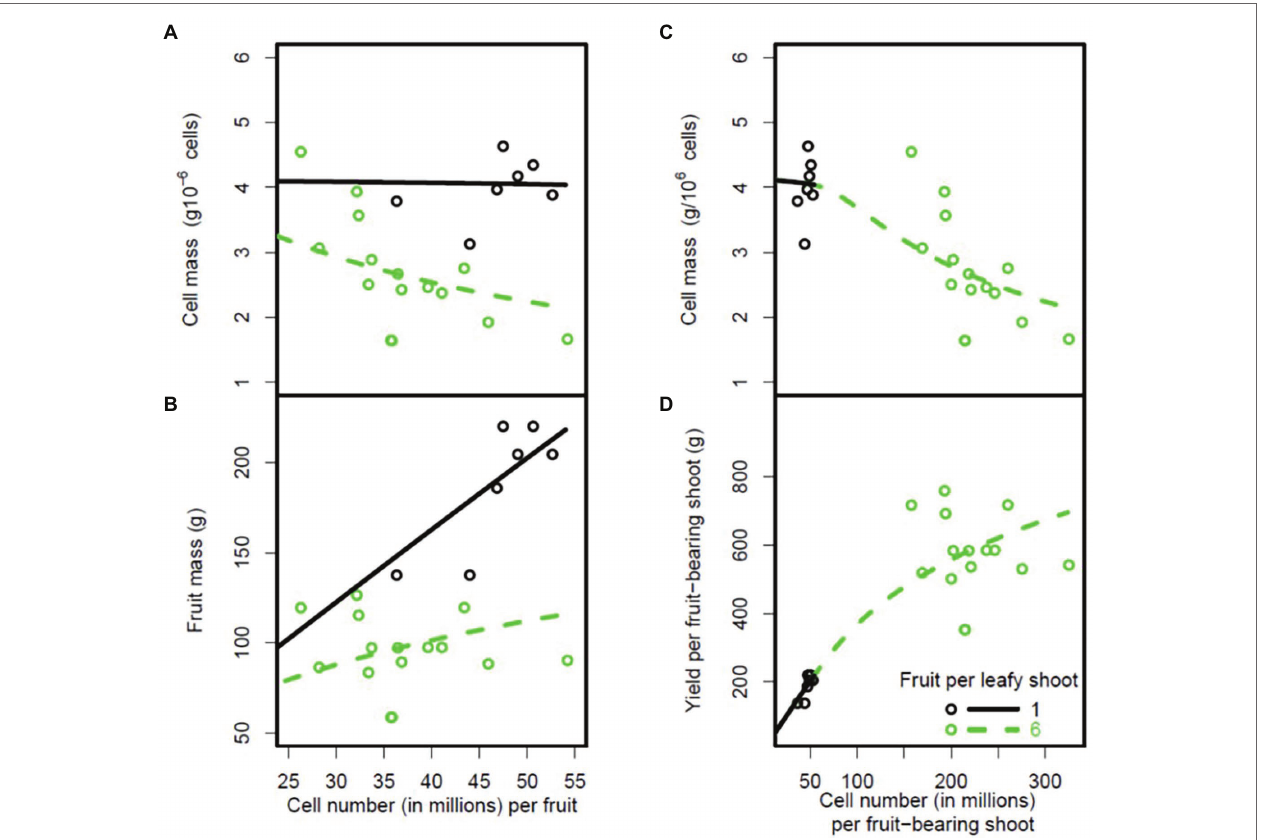
FIGURE 7 | Plots of cell mass and mass of peach fruit mesocarp at fruit maturity against number of cells in the fruit mesocarp (A,B) for two fruit loads. Plots of cell mass and total mass per fruit-bearing shoot against number of fruit cells on the shoot (C,D) . The circles are the experimental data and the lines are model predictions based on the parameter estimates shown in Supplementary Table 3 . The black circles and thick lines correspond to a fruit load of one fruit per leafy shoot and the open circles and thin lines correspond to a fruit load of six fruits per leafy